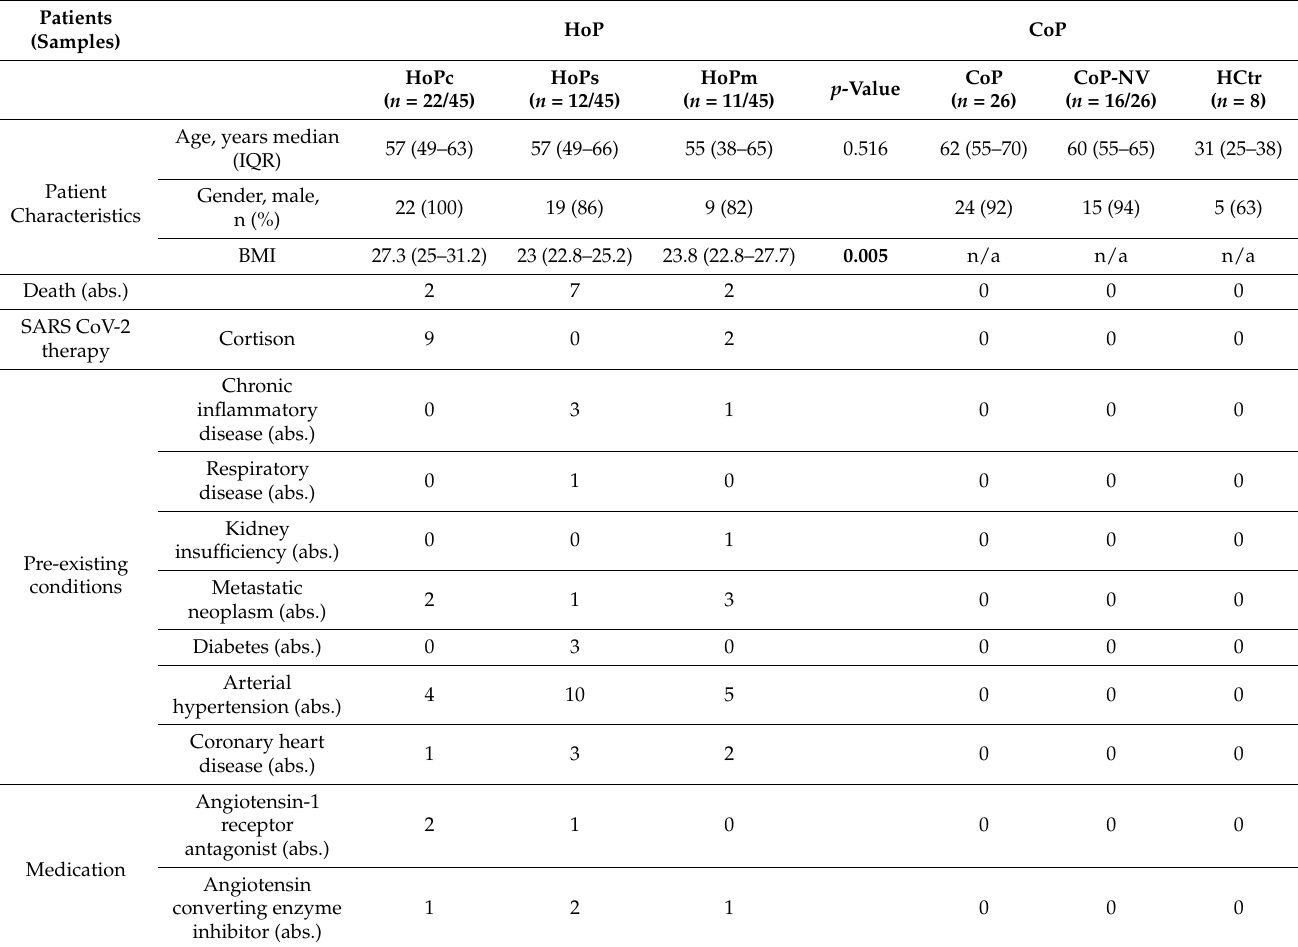
Table 1. Cohort characteristics: differences were calculated by Kruskal–Wallis test. IQR, interquartile range; BMI, body mass index; HoP, hospitalized patients with critical (c), severe (s) and moderate (m) disease; CoP, convalescent patients; CoP-NV, convalescent patients with normal values in the NRA; HCtr, healthy